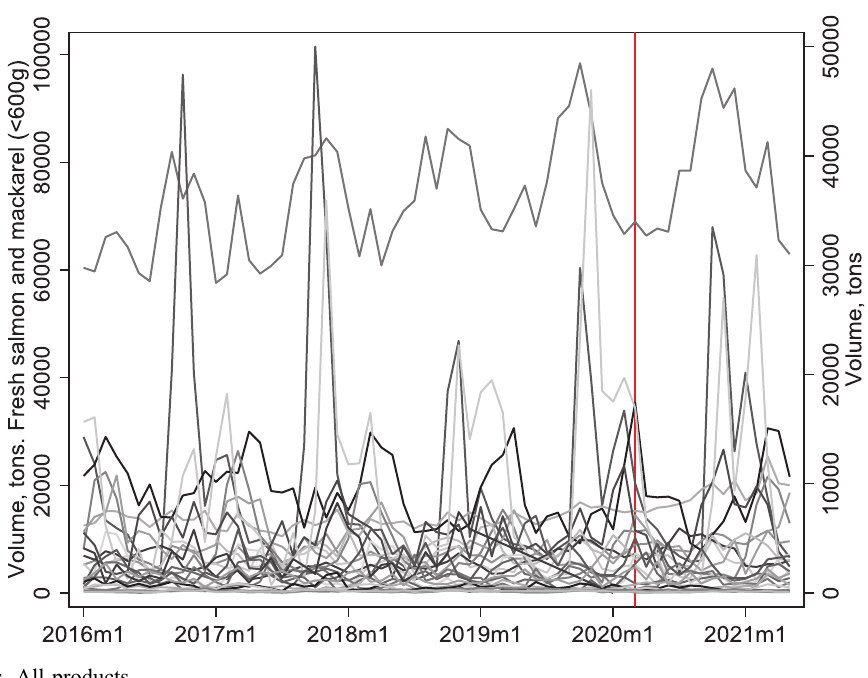
Fig. A2. Volume, tons. All